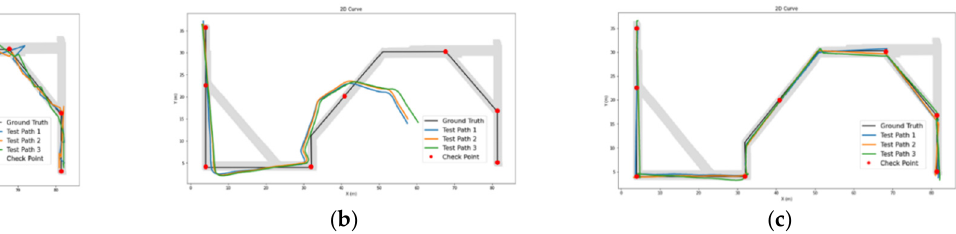
Figure 11. Positioning trajectory before and after coordinate constraint corrections.